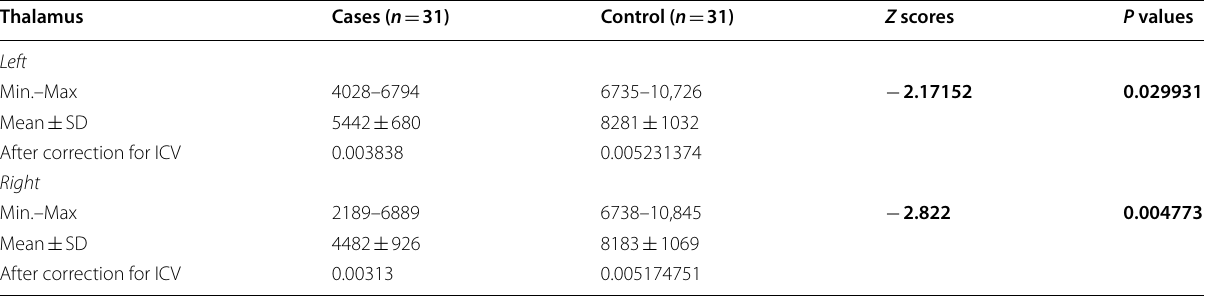
Table 4 Quantitative results of the left and right thalami, including absolute volumes, volumes after correction for ICV, Z scores and P values Thalamus Cases ( n